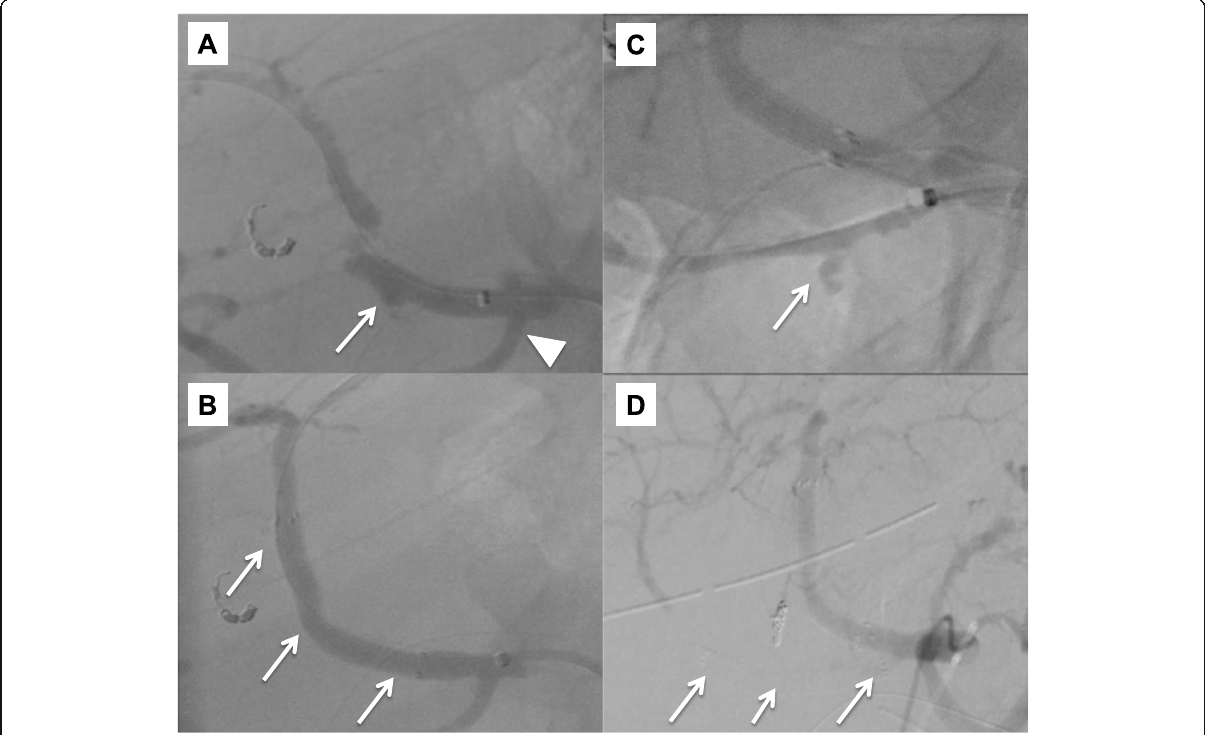
Fig. 1 Pre- and postoperative angiogram. a Angiogram reveals contrast extravasation from the pseudoaneurysm at the CHA (arrow). The RHA is branched independently from the CHA (arrowhead). b A stent graft, 6 mm in diameter and 5 cm in length, is placed from the CHA and distal part of the replaced RHA to the LHA (arrows). c Angiogram shows contrast extravasation from the RHA (arrow). d A stent graft, 5 mm in diameter and 5 cm in length, was placed in the RHA, but occluded soon after